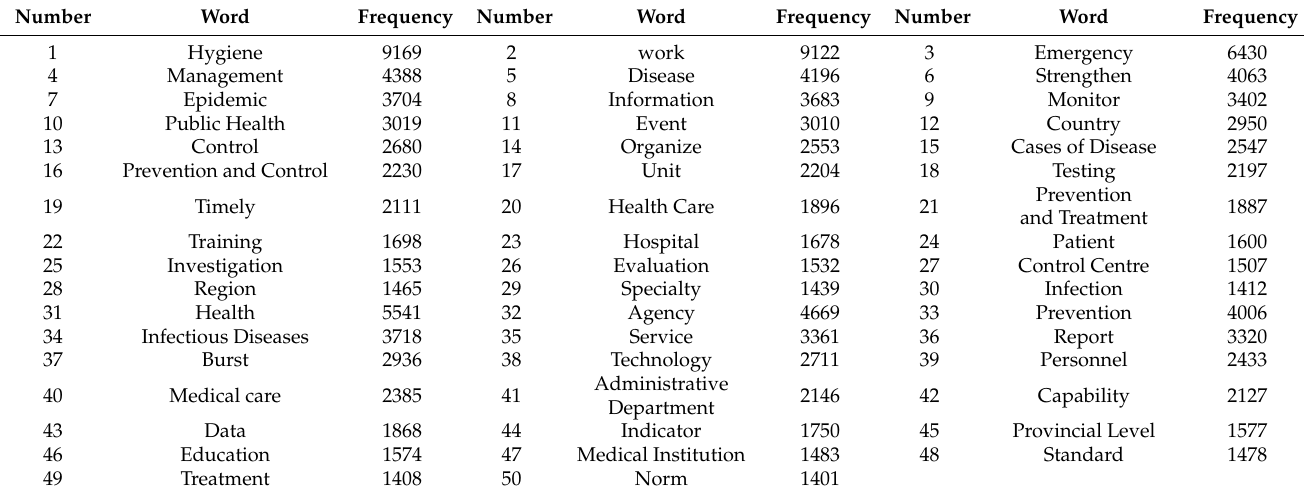
Table 3. Results of high frequency vocabulary